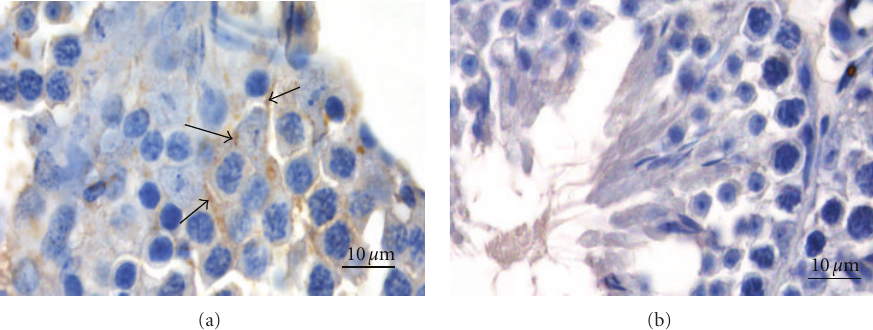
Figure 14: Immunohistochemicalanalysisfor Cx43 localizationin mice testes exposed for four weeks to V 2 O 5 inhalation.(a) Cx43 in control mice was localized between Sertoli cells and germinal cells (arrows). (b) Cx43 immunostaining was absent in exposed